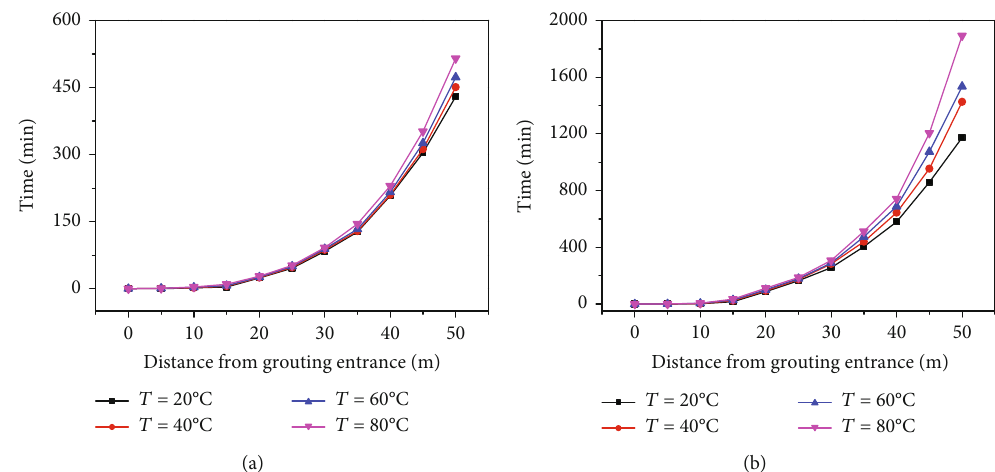
Figure 12: Time it takes for the grout to pass through di ff erent distances under di ff erent injection pressures: (a) 1MPa and (b) 0.5MPa.